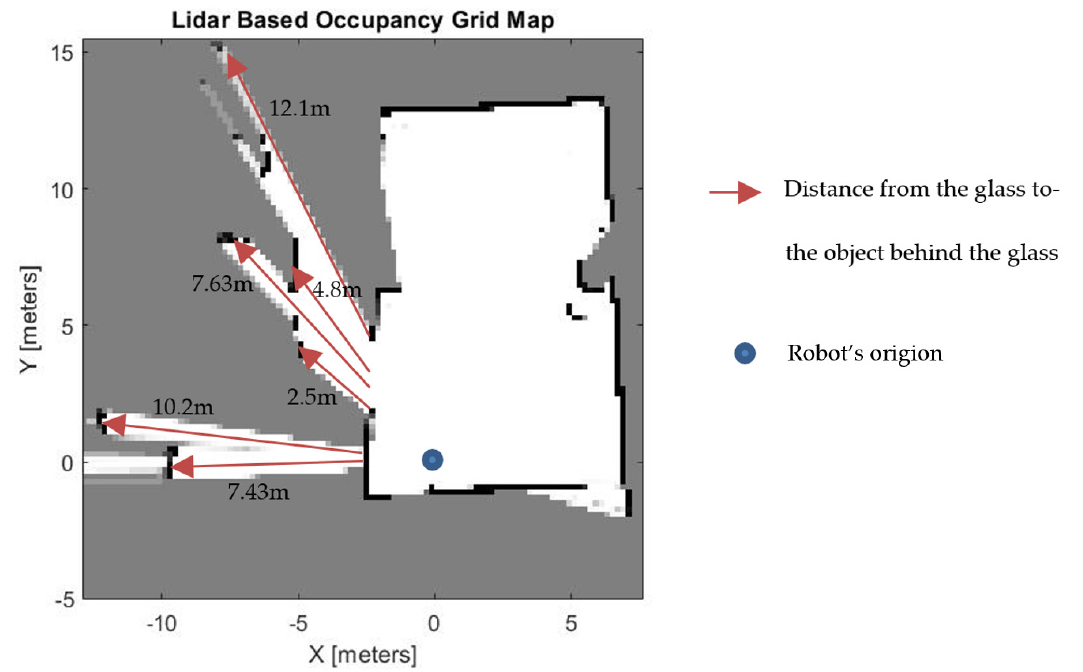
Figure 15. Evaluation of different distances between the glass and objects behind the glass.